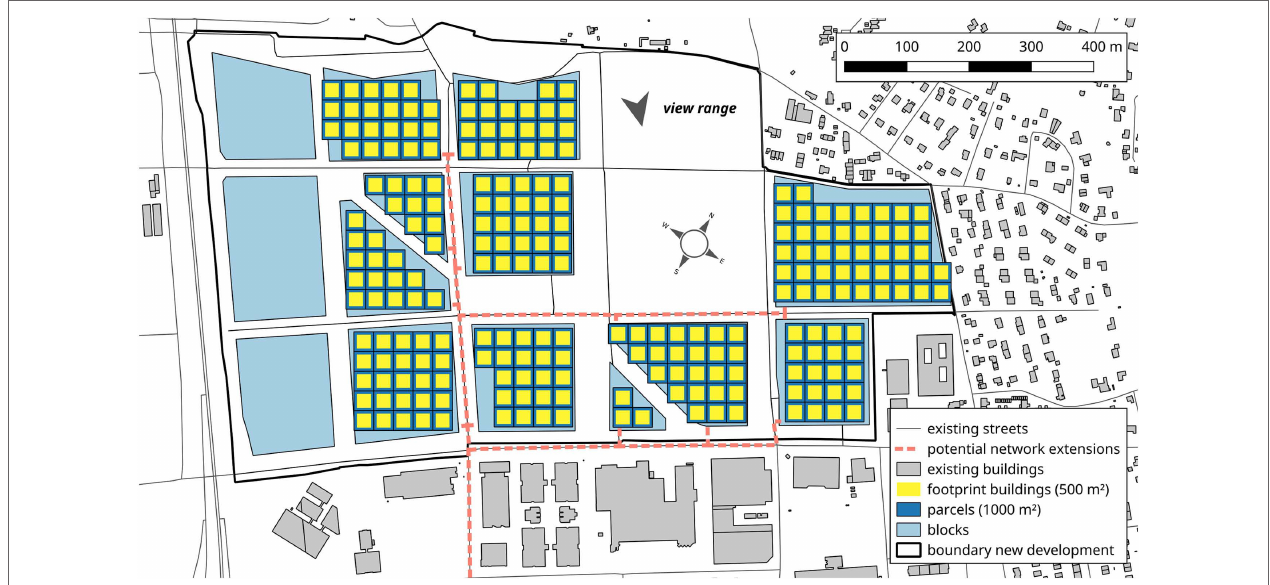
FIGURE 4 | Map of the case study Les